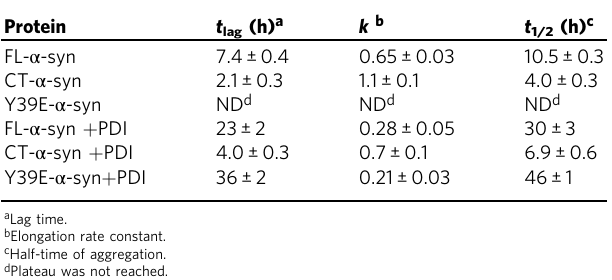
Fig. 4 Physiological and pathological consequences of CT- α -syn. a Representative confocal images of JC-1-stained SK-N-SH cells after 5 h treatment with 50 μ M FL- α -syn and CT- α -syn at 37 °C. Scale bar = 2 μ m. b Integrated fl uorescence intensities of fi ve random visual fi elds were analyzed with Image J software using the mean ratio of green to red fl uorescence to indicate mitochondrial damage. Uncertainties are the standard error of the mean from three biologically independent experiments. Statistical analysis were performed by one-way ANOVA for multiple comparisons. p < 0.05 was considered statistically signi fi cant difference (* p < 0.05; ** p < 0.01; ns, not signi fi cant). c Cytochrome c levels were assessed by Western blotting after incubating isolated mitochondria with increasing concentrations of FL- and CT- α -syn at 37 °C for 1 h. Unincubated mitochondria served as positive controls. d Dynamic light scattering-measured particle size of POPC/CL (7:3 mole ratio) liposomes alone (purple line), or after incubation with FL- (green line) or CT- α -syn (orange line) for 30 min. e Aggregation kinetics of 0.3 mM FL- and CT- α -syn in the absence and presence of equimolar PDI monitored by